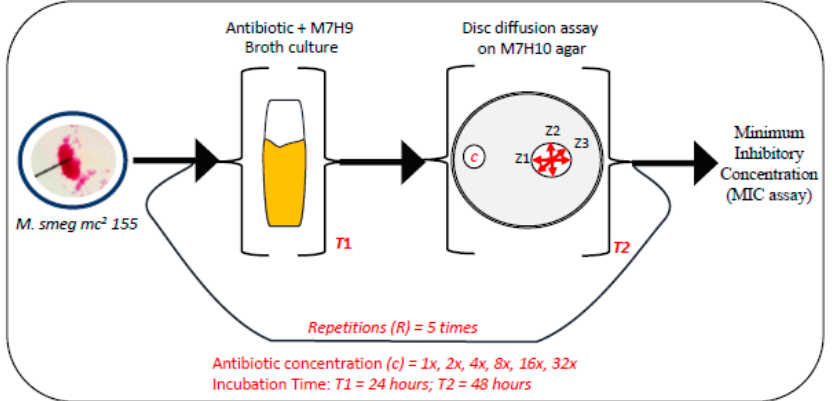
Figure 1. Generating multidrug-resistant (MDR) clones of Mycobacterium smegmatis , in vitro. Single